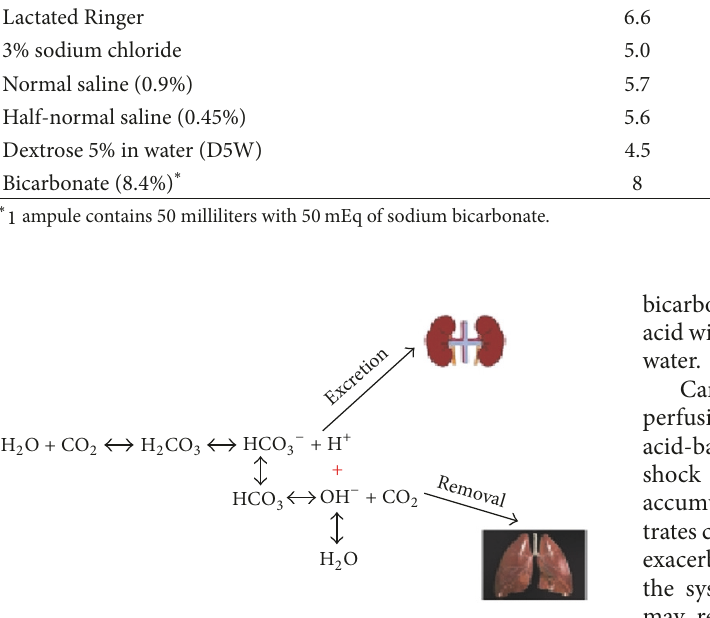
Figure 1: An overview of the endogenous bicarbonate